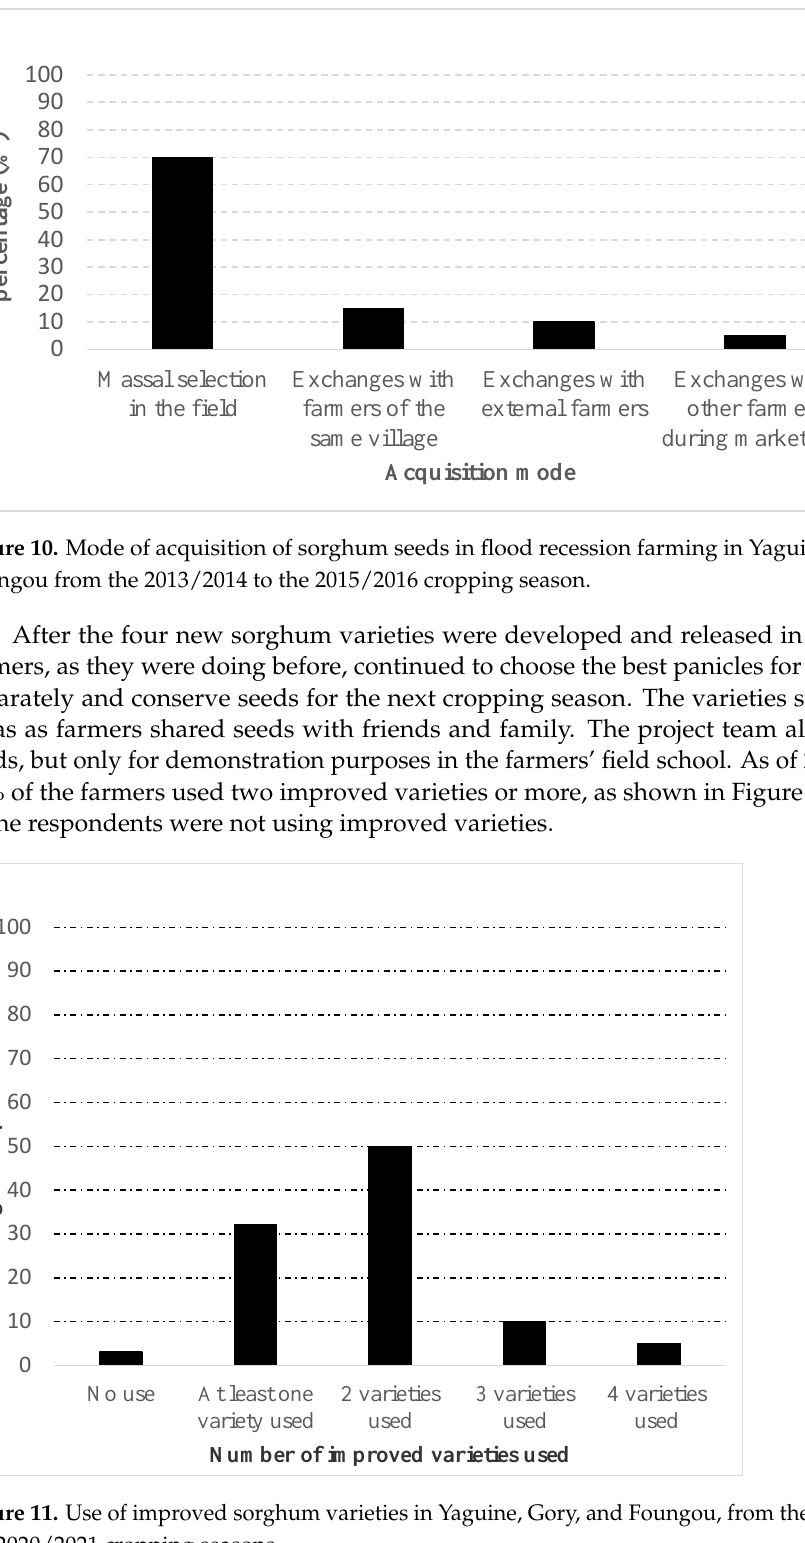
Figure 9. Relationship between grain yield and preference index in the 2014/2015 season.